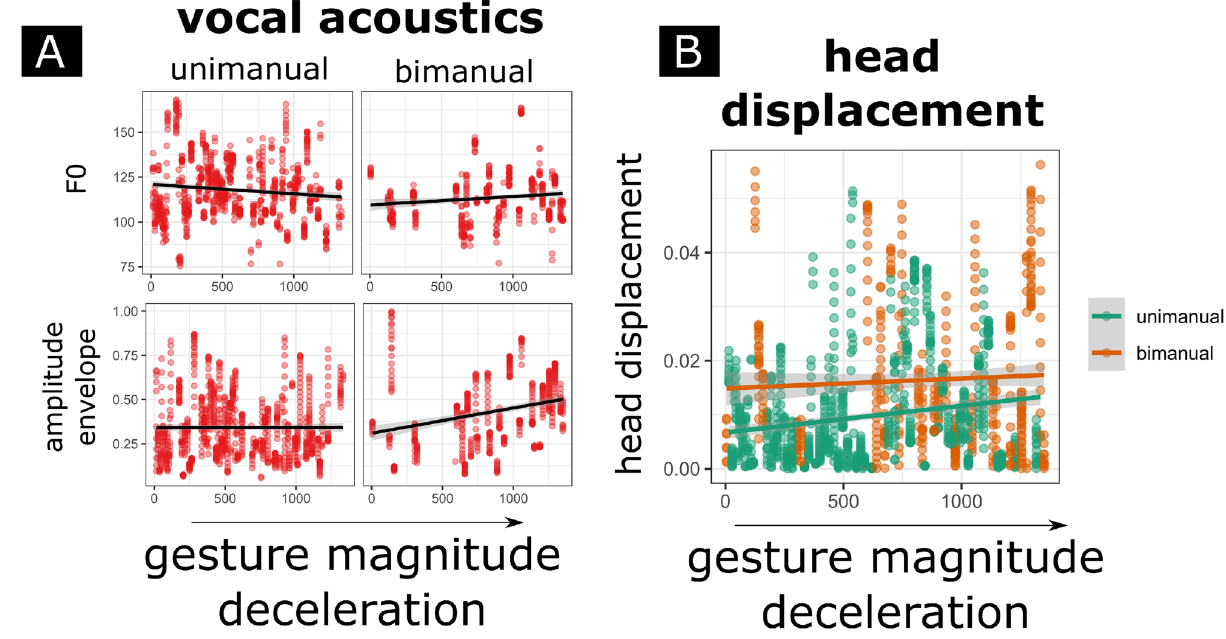
Figure 5. Acoustic and head displacement correlates with physical impulse. Note . On the x-axes, the magnitude of the deceleration (rank ordered absolutized deceleration) is given. For ( A ), the acoustic samples 200 ms around peak deceleration are plotted on the y axes, for F0 (upper; y-values in Hz) and amplitude envelope (lower; y-values in arbitrary units) subpanels. It can be seen that for bimanual gestures, a higher gesture deceleration magnitude relates to a higher acoustic output for F0 and amplitude envelope. ( B ) The relation between gesture deceleration and the displacement of the head around moments (same 200 ms sample) of peak deceleration. Head displacement is more pronounced for higher deceleration, especially for unimanual gestures. Further, bimanual gestures have in general more pronounced head displacement as indicated by the higher intercept as compared to unimanual